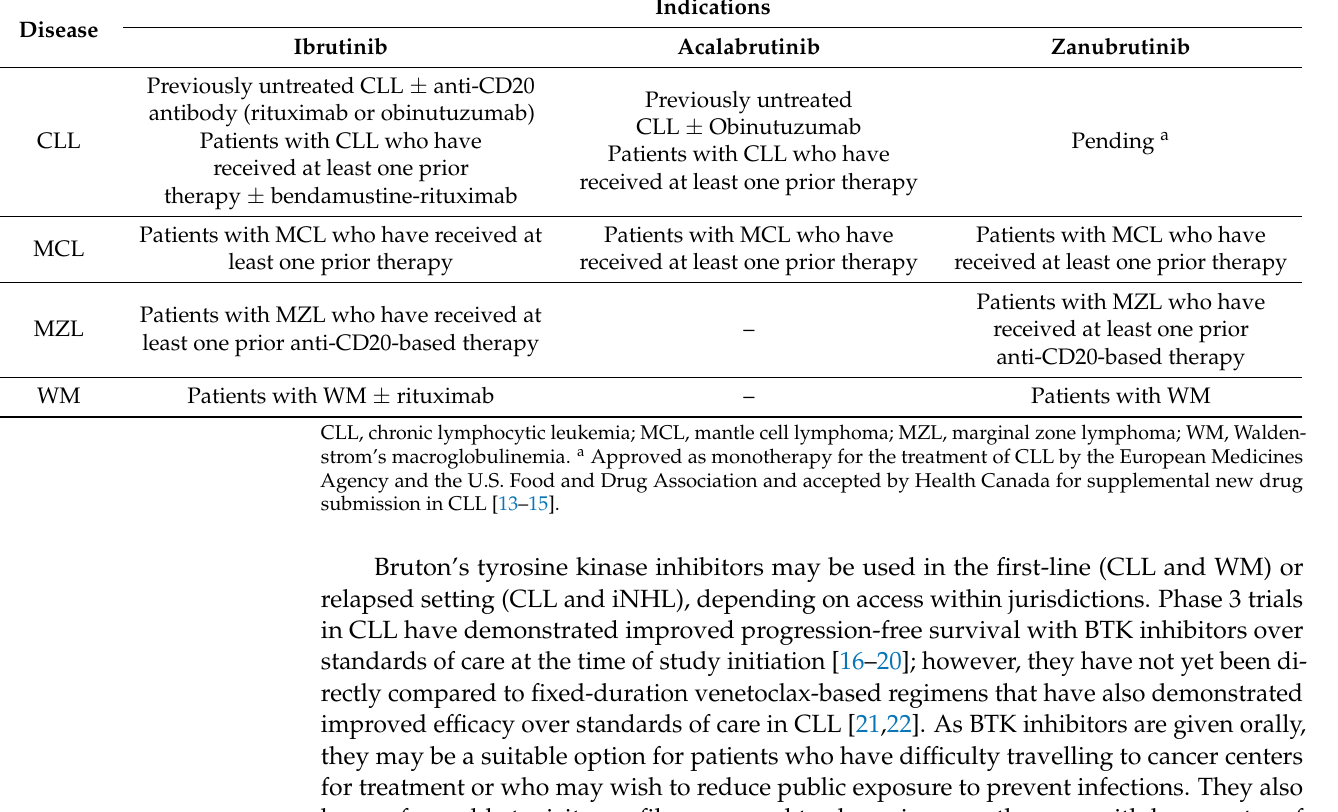
Table 1. Health Canada indications for Bruton’s tyrosine kinase inhibitors in B-cell malignancies.